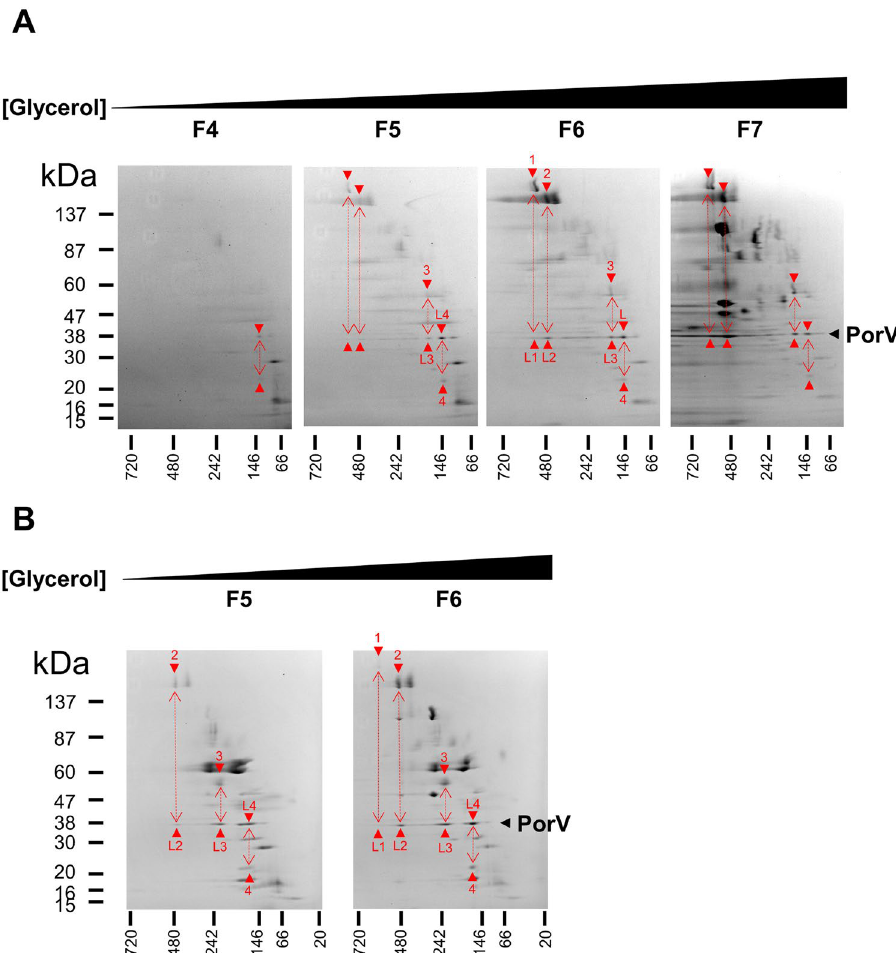
Figure 5. PorV interacts with immature T9SS substrates in porU mutants. Coomassie stained 2D BN-PAGE of rate-zonal glycerol density gradient centrifugation fractions of DDM solubilized OMVs from ( A ) W50 porU or ( B ) 33277 porU C690A . Fractions analysed are shown above. Red double sided arrows indicate proposed interacting proteins and red arrowheads point to individual protein spots, some of which were identified by MS and labeled for ( A ) as: L (L1, L2, L3, L4), PorV; 1, HagA; 2, mix of Kgp and RgpA; 3, TapA (PG2102/P59); 4, PG2172 (see Supplementary Table S3). Labeled for ( B ) as: L (L1, L2, L3, L4), PorV; 1, HagA (was not confirmed by MS); 2, mix of Kgp and RgpA; 3, RgpB; 4, PG2172 (see Supplementary Table